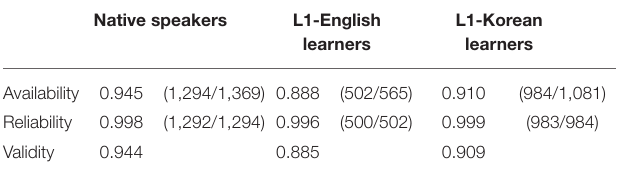
TABLE 12 | Availability, reliability, and validity of cues in all sentences. Native speakers